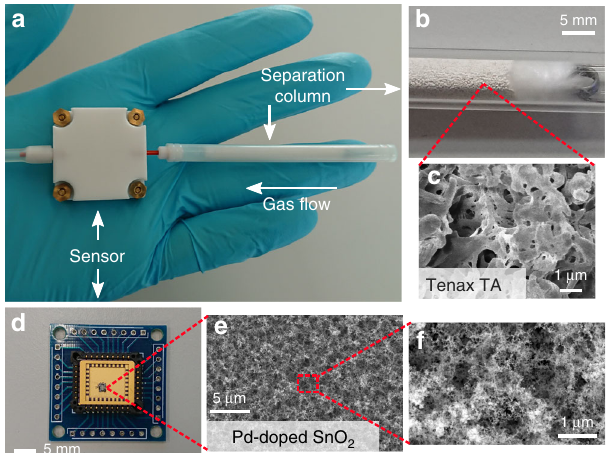
Fig. 1 Images of the handheld methanol detector. a It consists of a microsensor (in Te fl on housing) connected to a separation column (Tenax TA particles in Te fl on tube). b Close-up of the separation column with particles inside a glass tube for better visibility. c Magni fi ed images of a particle ’ s surface. d The sensor chip carrier with a mounted microsensor. e , f Top-view images of the sensing fi lms consisting of a fi ne network of agglomerated and aggregated Pd-doped SnO 2